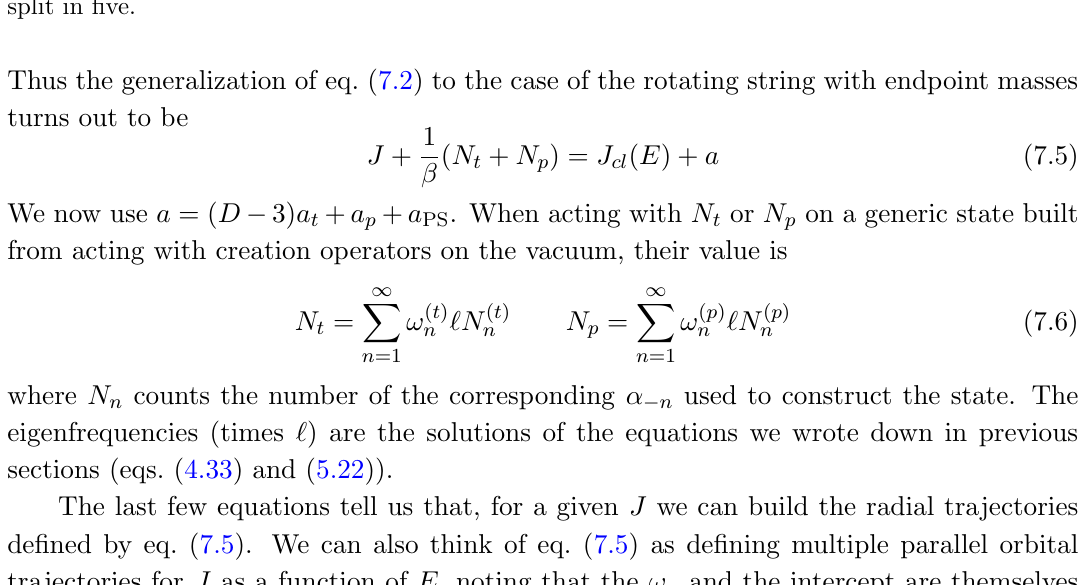
Table 1 . The (cid:12)rst two excited states and their masses. In total there are D (cid:0) 2 states with N = 1 and ( D (cid:0) 2) 2 + 1 with N = 2, as expected. The level N = 1 is split in two, and the level N = 2 is split in